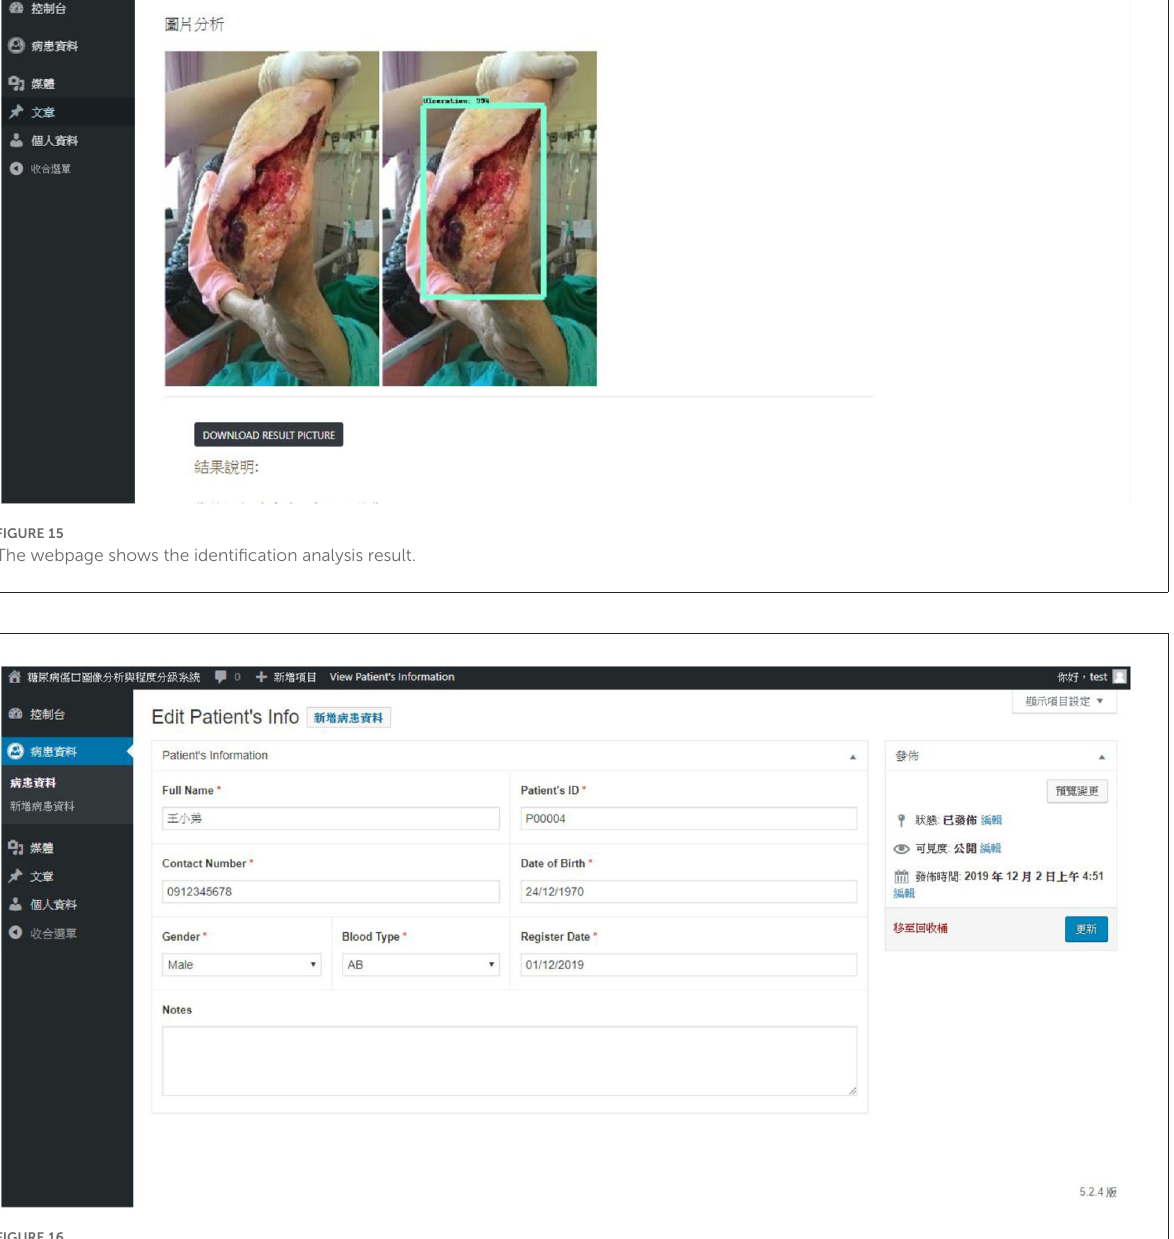
FIGURE16 Another patient data query